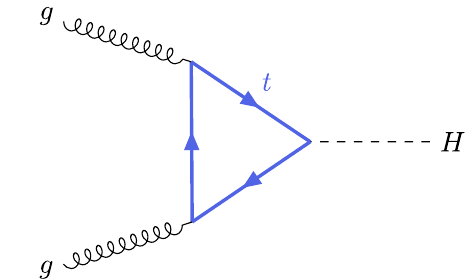
Fig. 1 Leading order diagram for Higgs production in gluon fusion at hadron-hadroncolliders.Thequarkrunningintheloopispredominantly a